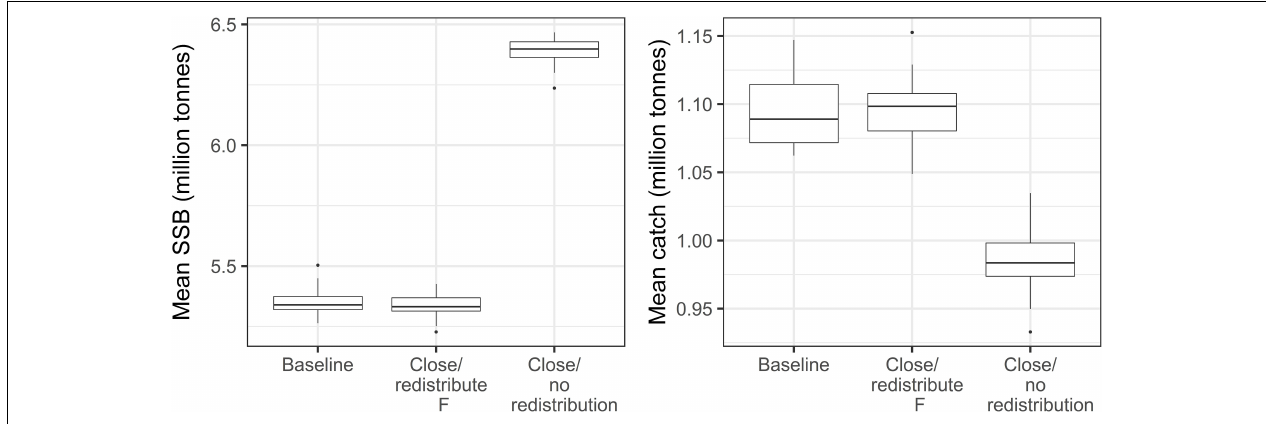
FIGURE 5 | Mean SSB (left panel) and annual catch (right panel) over the period 2021–2050 under three scenarios: (1) baseline, i.e., ICES division 4a is closed from February 15th to July 31st as at present (2019) and F is raised elsewhere to account for this; (2) division 4a is closed for the entire year and F is raised elsewhere to account for this; and (3) division 4a is closed all year and F is not redistributed, i.e., there is an overall reduction in F. Boxplots show medians and interquartile ranges, representing variability arising from stochasticity the IBM and uncertainty in the parameter